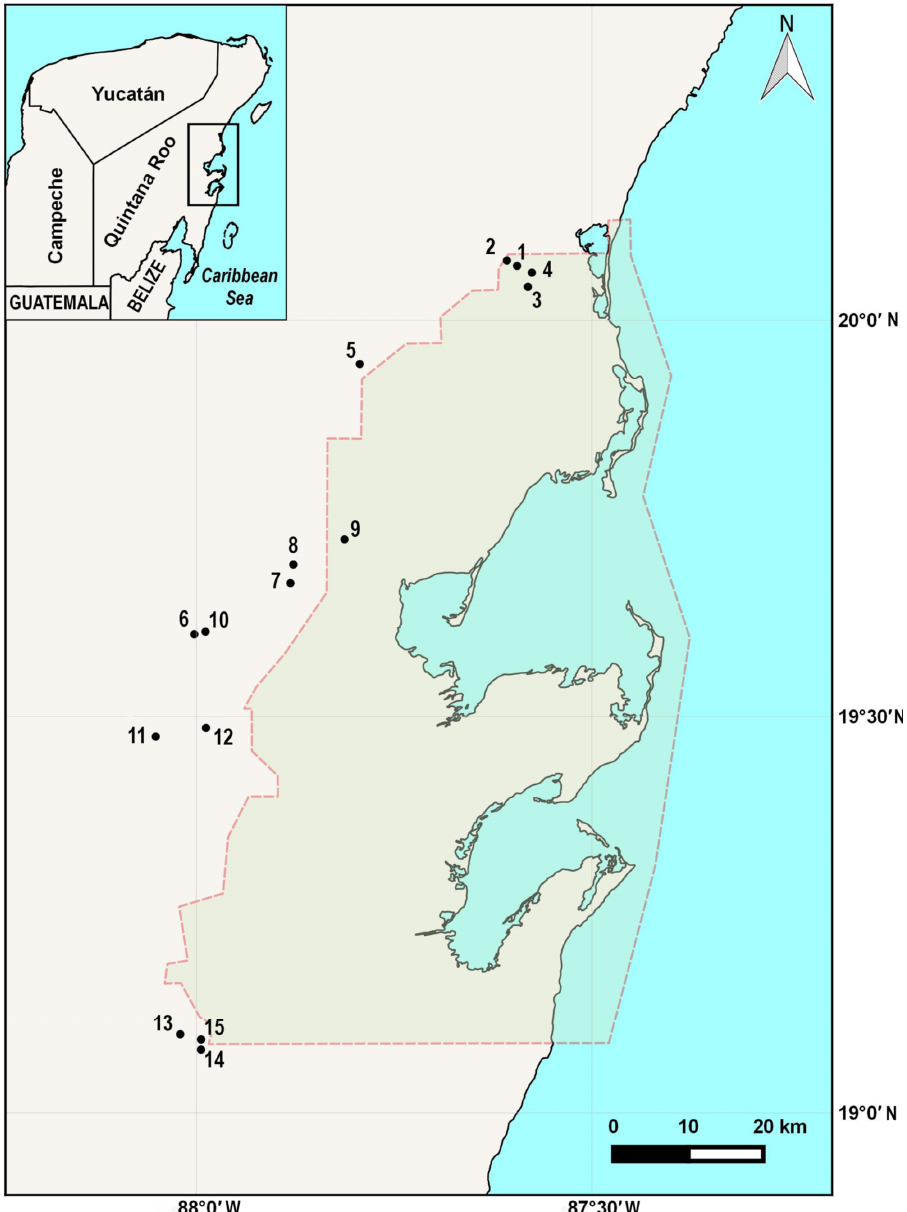
Figure 1. Map of the Yucatan Peninsula’s east coast with localities sampled. Dotted lines show the limits of the Sian Ka’an reserve. Numbers of localities are the same as Table 1.